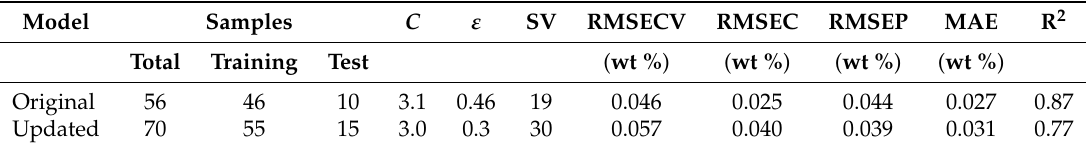
Table 2. Summary of the optimisation parameters and performance indicators of the original [6] and updated support vector regression (SVR) calibrations.